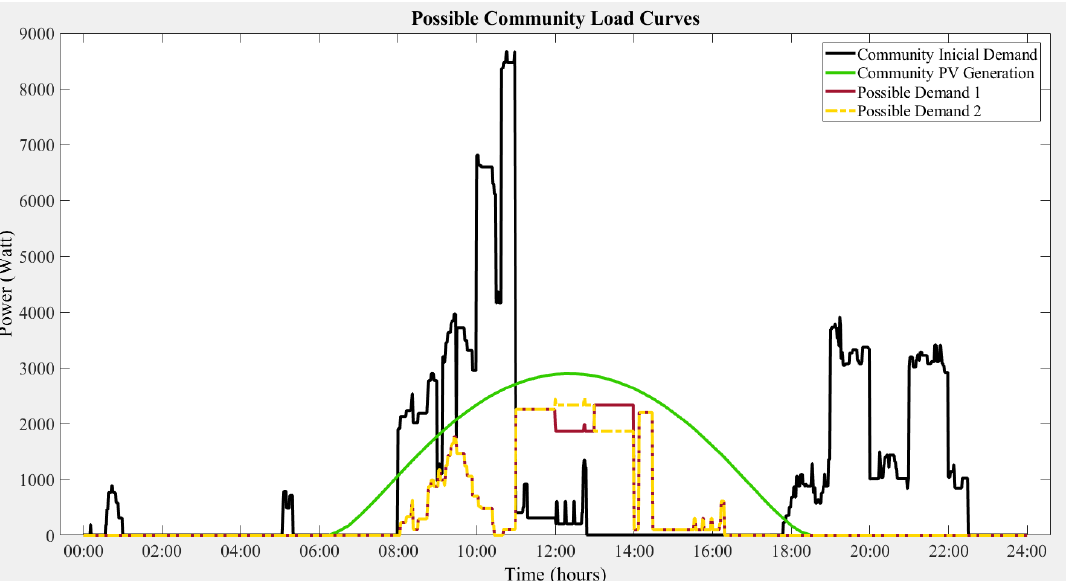
Figure 14. Possible solutions for the community ’ s demand profile regarding Scenario